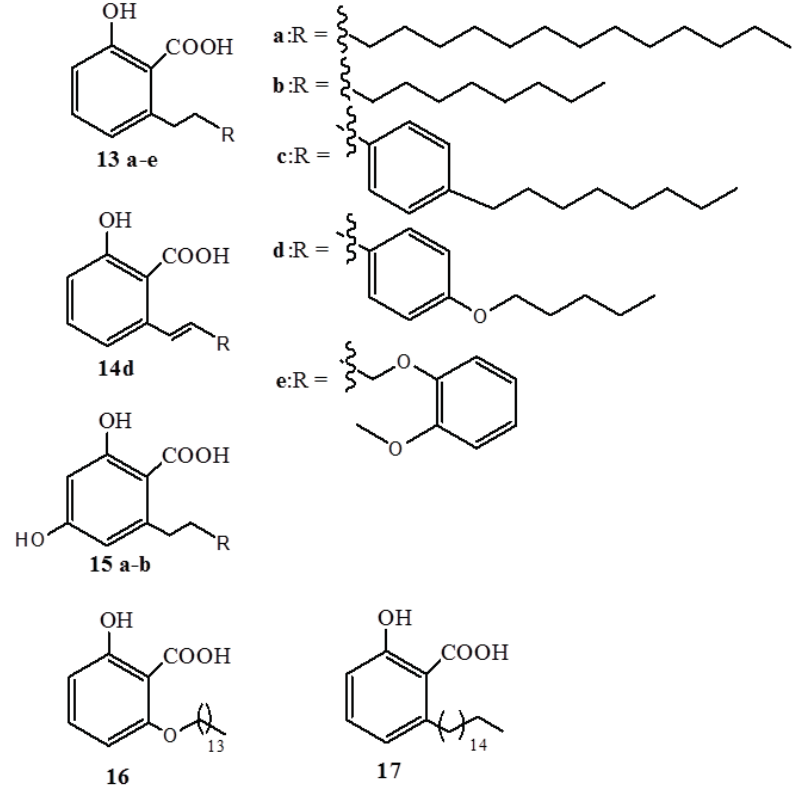
Figure 5. Synthetic anacardic acids 13 – 17